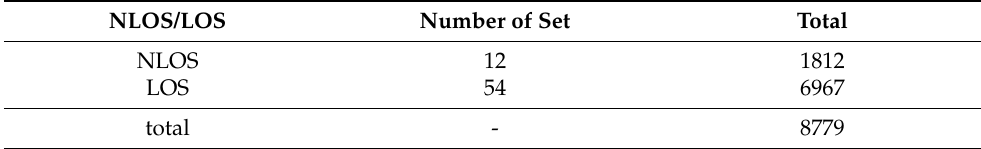
Table 2. The amount of sample data needed to train the model